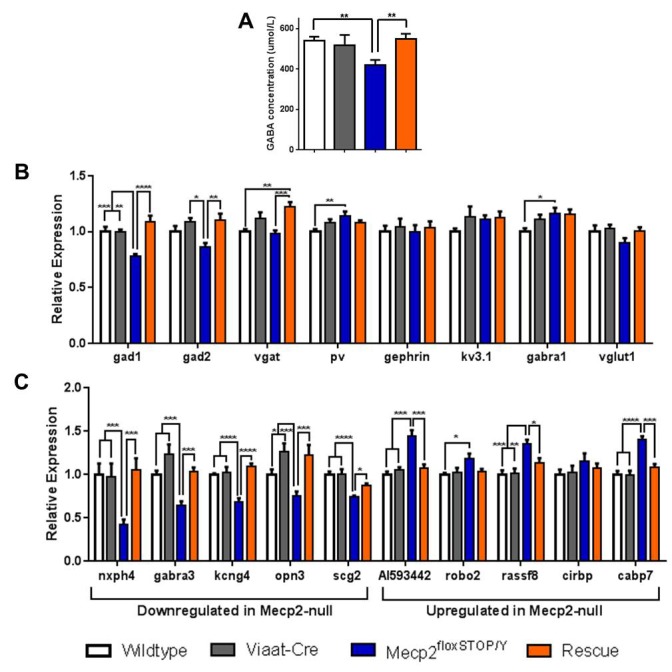
Expression of Mecp2 in GABAergic neurons normalizes levels of GABA and other MeCP2 responsive genes.(A) GABA concentrations were restored to wildtype levels in striatum from rescue mice (n = 4–5 per genotype). (B) RNA expression of genes related to GABAergic neuronal function, particularly gad1 and gad2, were normalized in rescue mouse cerebella. (C) Genes known to be downregulated or upregulated in Mecp2-null cerebellum were normalized in the rescue mice. Error bars show SEM. *p< 0.05 **p<0.01 ***p<0.001 ****p<0.0001. n = 6–7 per genotype.